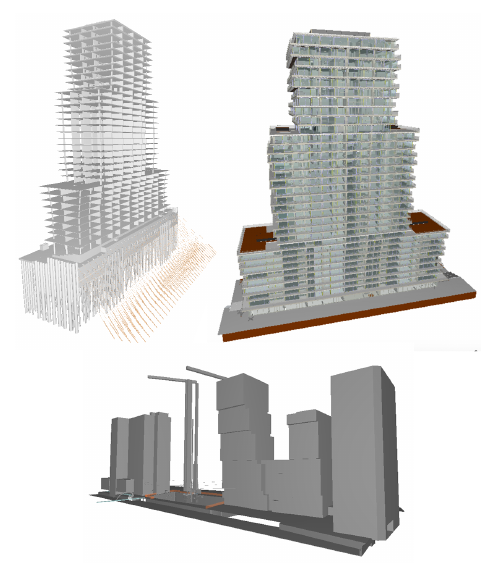
(Clemen and Hendrik, 2019).